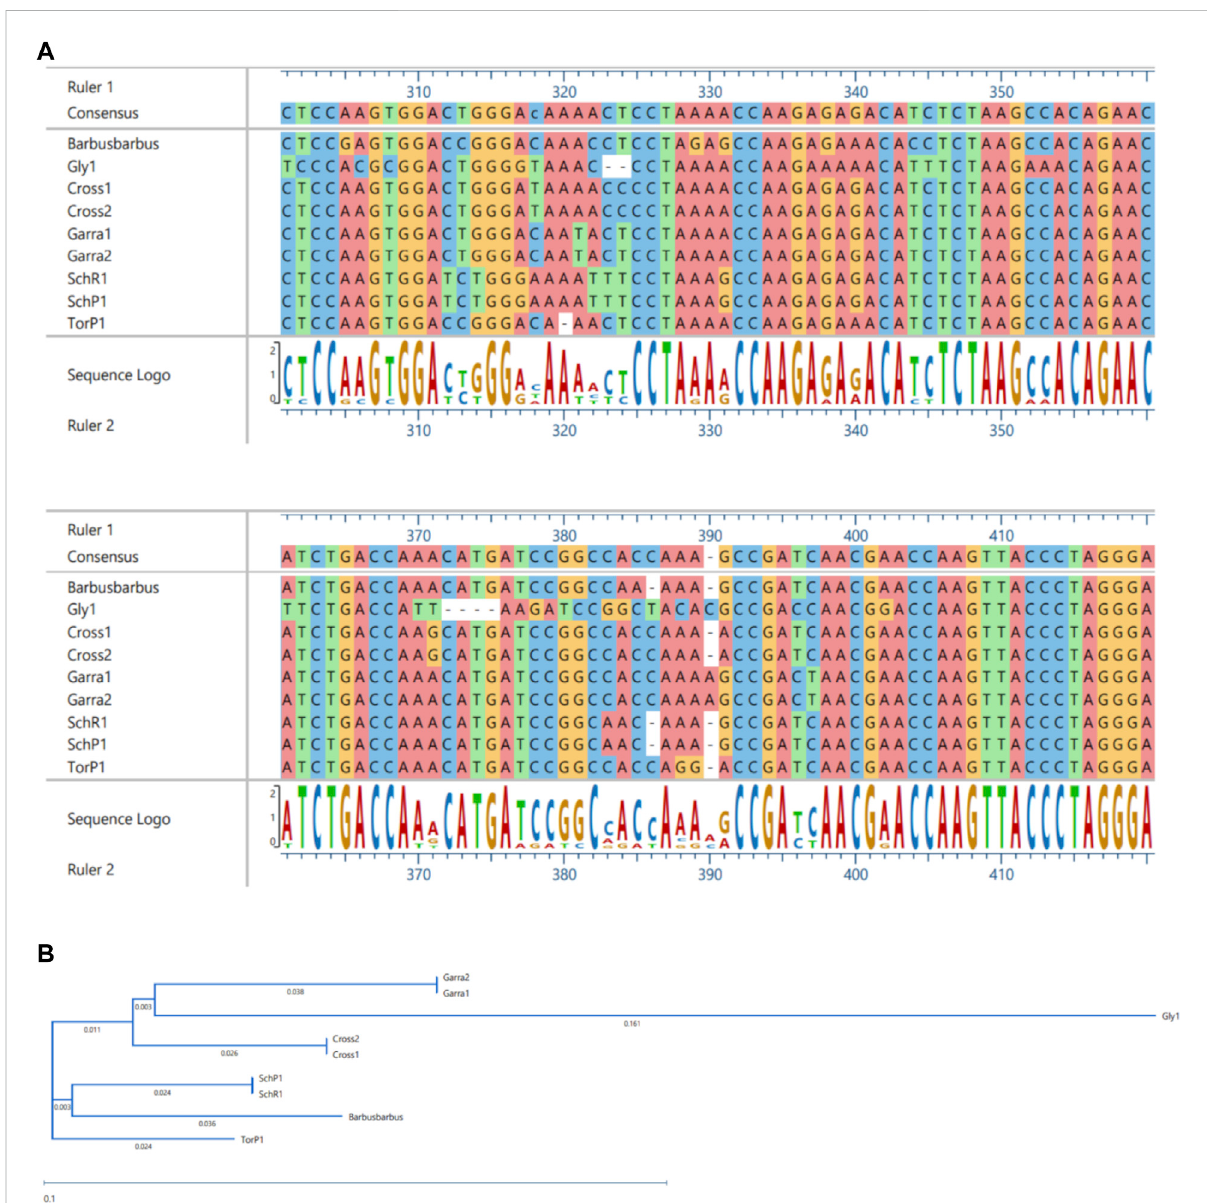
MSA (A) and Phylogenetic Tree (B) of 16S sequences. MSA was performed using MUSCLE Program and Phylogentic analysis were performed using PhyML algorithm (parameters — bootstrap value = 100, tree search = “ Best from NNI and SPR, ” Sarting tree = “ BioNJ, ” equllibrium and site rate variation = “ Optimized ”